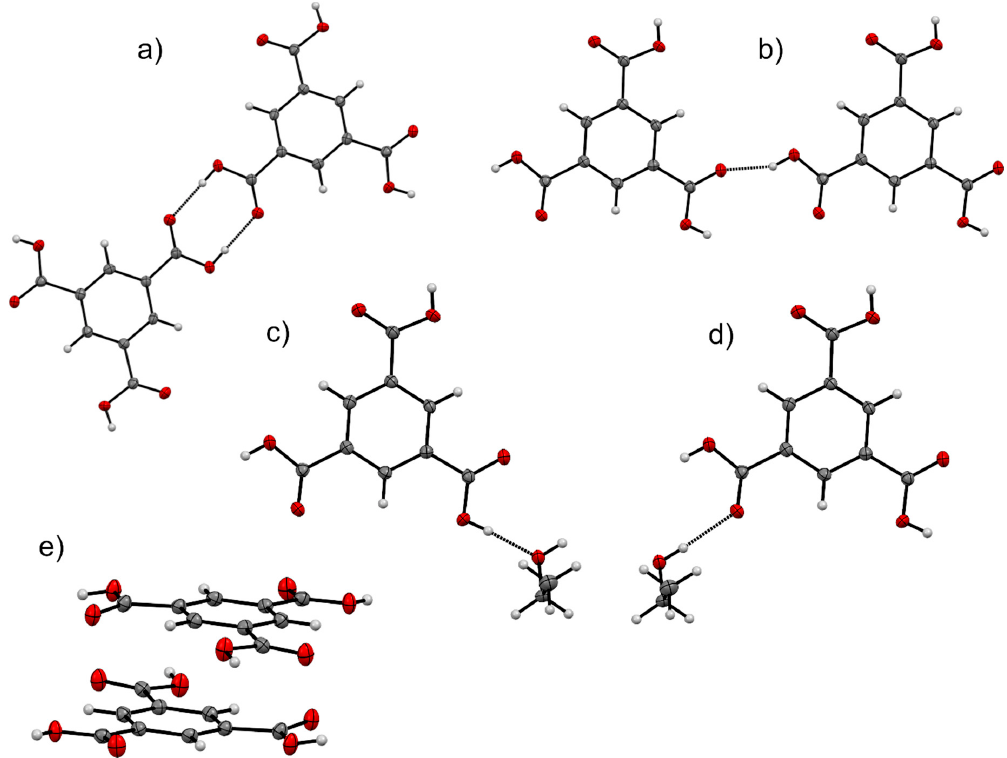
Figure 5. The strongest intermolecular interactions that are common to all the TMA alcohol solvates. The letters ( a – e ) correspond to the interactions in Table